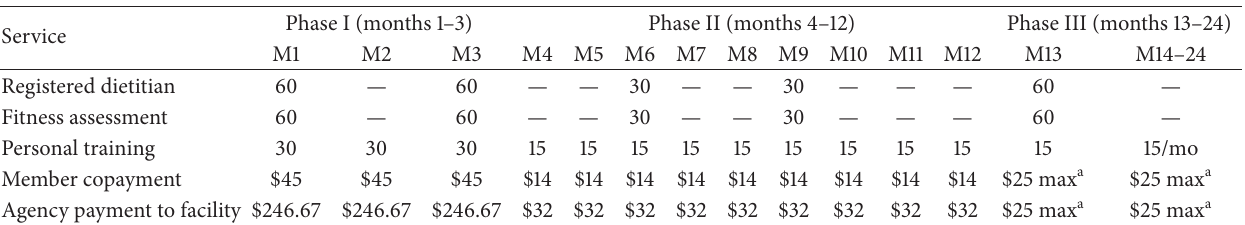
Table 1: Minutes of services per participant and monthly reimbursement made by the insurer during the weight management program. Service